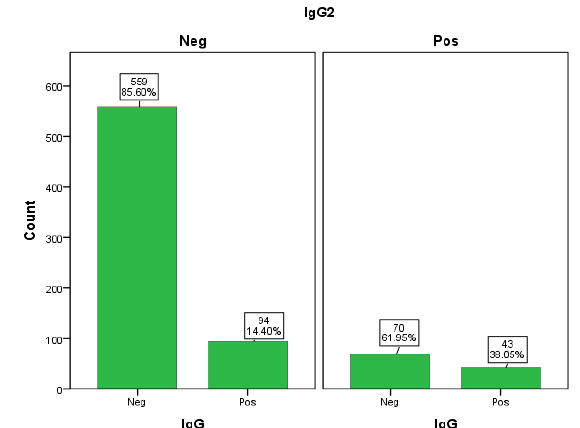
Figure 2. IgG in Two Time Points. Note . IgM: Immunoglobulin M; IgG: Immunoglobulin G. IgG and IgG2 are for the first second stages, respectively. Neg: Negative; Pos: Positive.